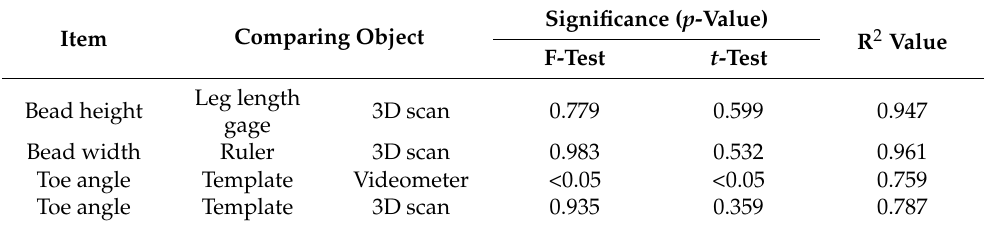
Table 5. Summary of gage R&R for each weld profile.